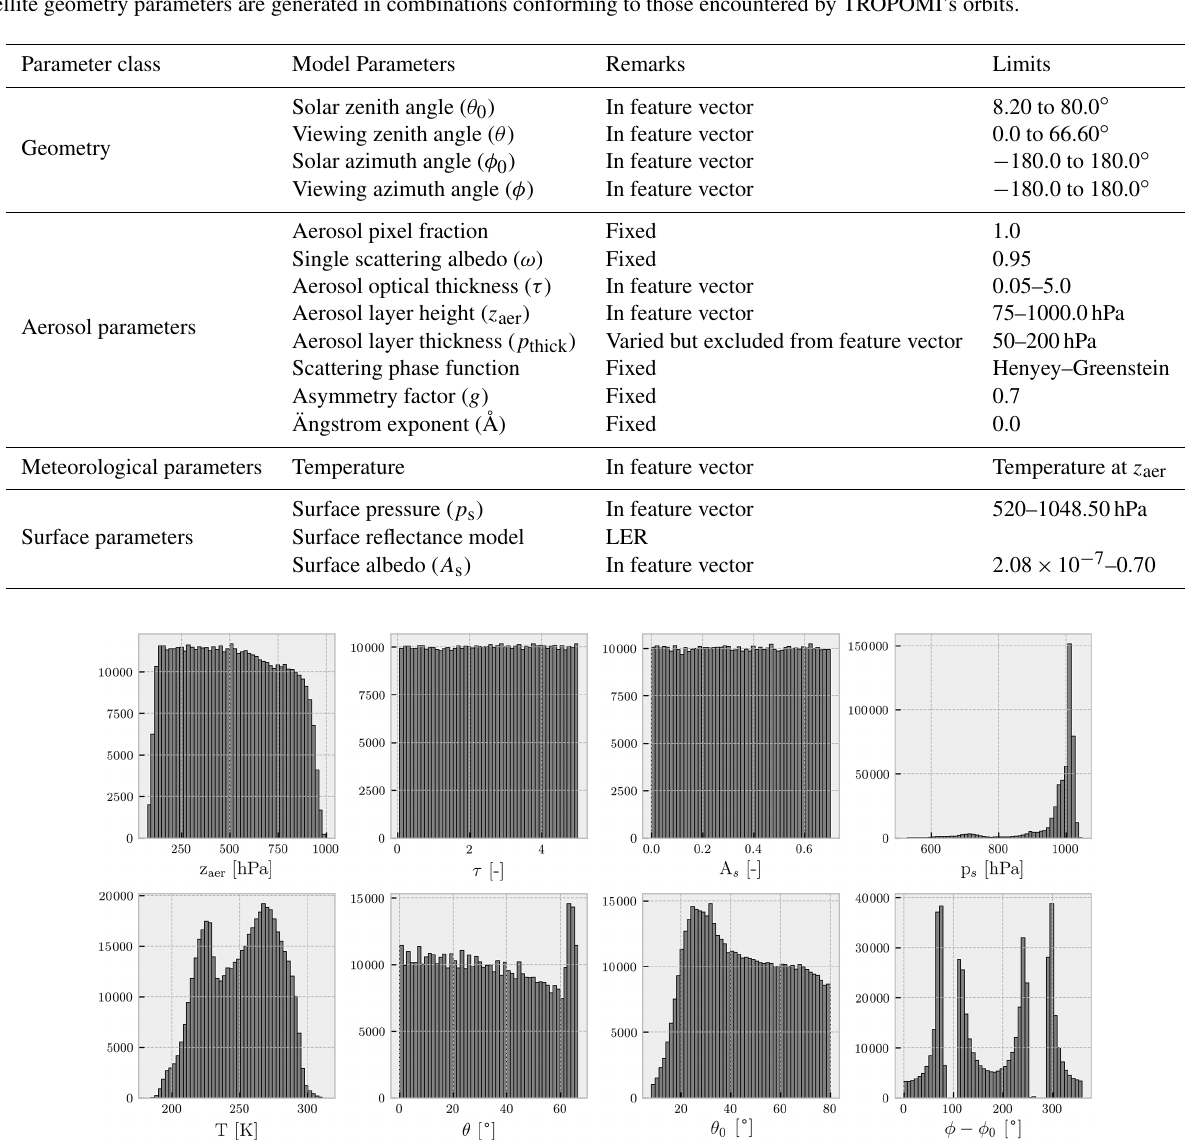
Figure 1. Histograms of the various input parameters for each of the neural network models in NN. Minimum and maximum values for each of the parameters are shown in Table